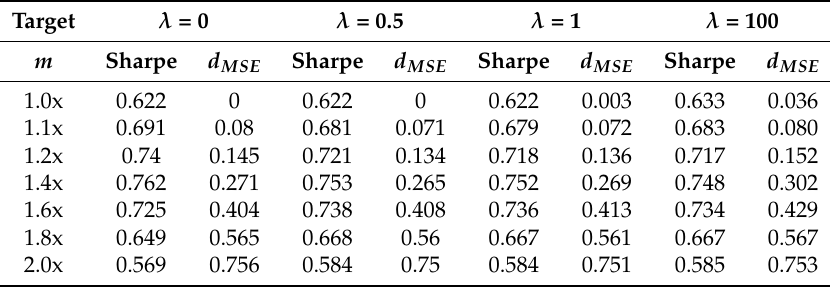
Table 3. In-Sample MSE Distance to RP with increasing λ